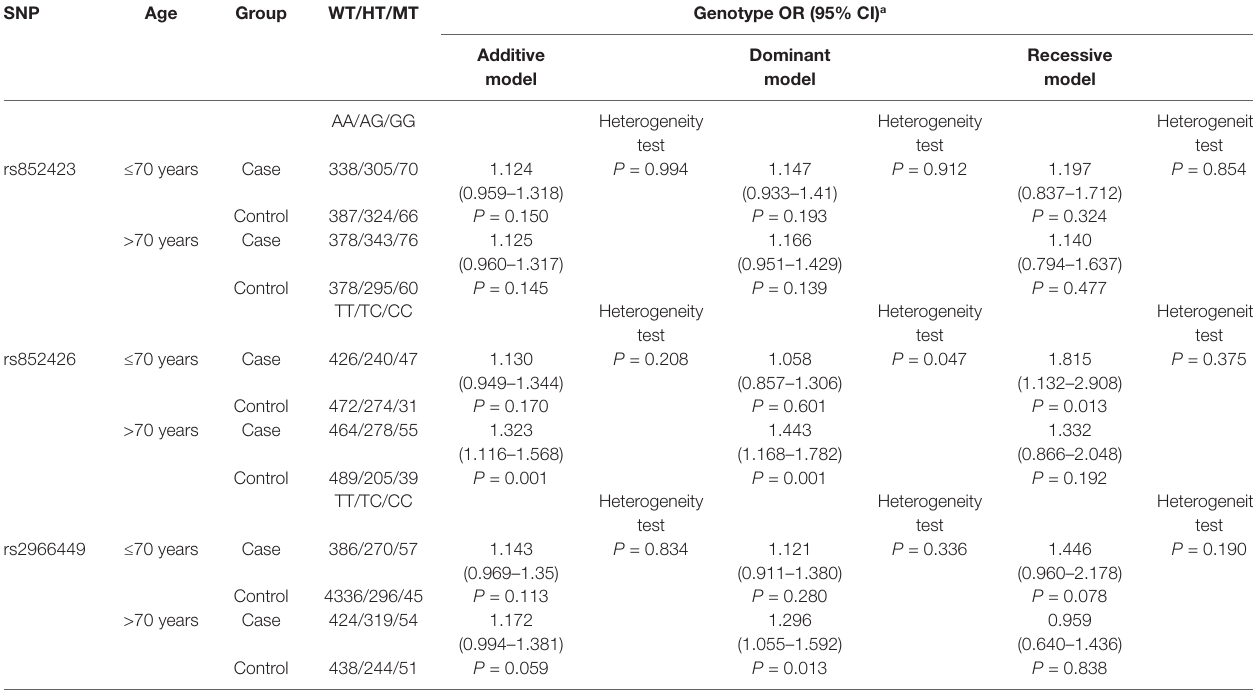
TABLE 3 | Stratified analysis of the ACTB gene with DKD by age.